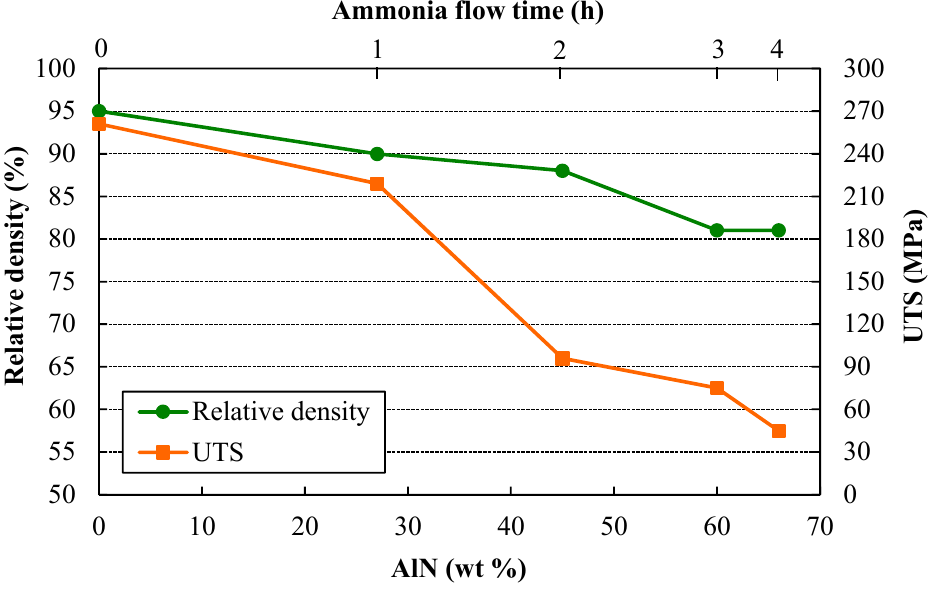
Figure 5. Relative density and UTS (Ultimate Tensile Strength) versus AlN wt % of the different sintered compacts.